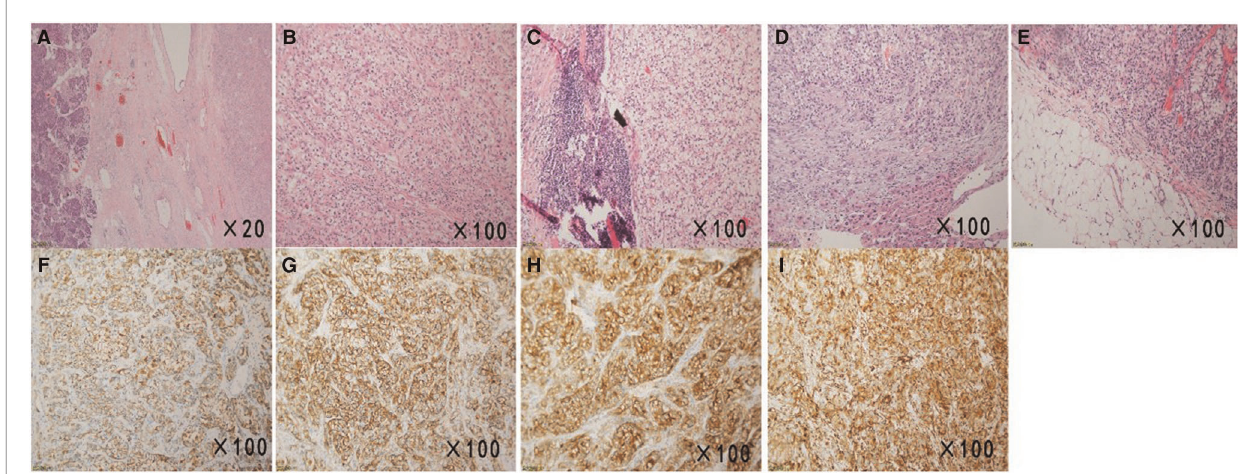
FIGURE 2 | Micrographs of the surgical specimens and immunohistochemical examination results. ( A,B ) Sections of the pancreas showed atypical clear cells monomorphonuclear with bright cytoplasm ( H&E , ×20, ×100). ( C – E ) HE staining image of the peripancreatic lymph node, sections of the liver, and the omental tissue showed histological features similar to those of the pancreatic sections ( H&E , ×100, ×100, ×100). ( F – I ) Immunohistochemical examination of surgical specimens showed neoplastic cells with CK (+), CA9 (+), CD10(+), and Vimentin (+) (×100).